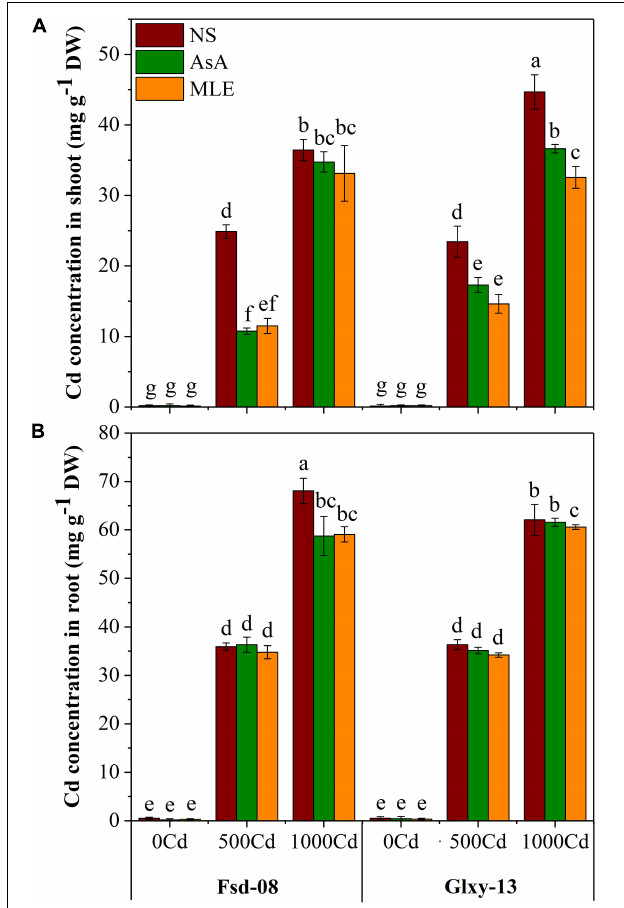
FIGURE 5 | Accumulation of Cd in shoot (A) and root (B) , under the foliar spray of AsA and MLE, along with NS in two wheat cultivars (Fsd-08 and Glxy-13) exposed to the Cd toxicity. Different lowercase letters denote the significant difference as determined by LSD test ( p < 0.05, n = 4). AsA and MLE were applied at the rate of 50 mM and 3% (w/v),